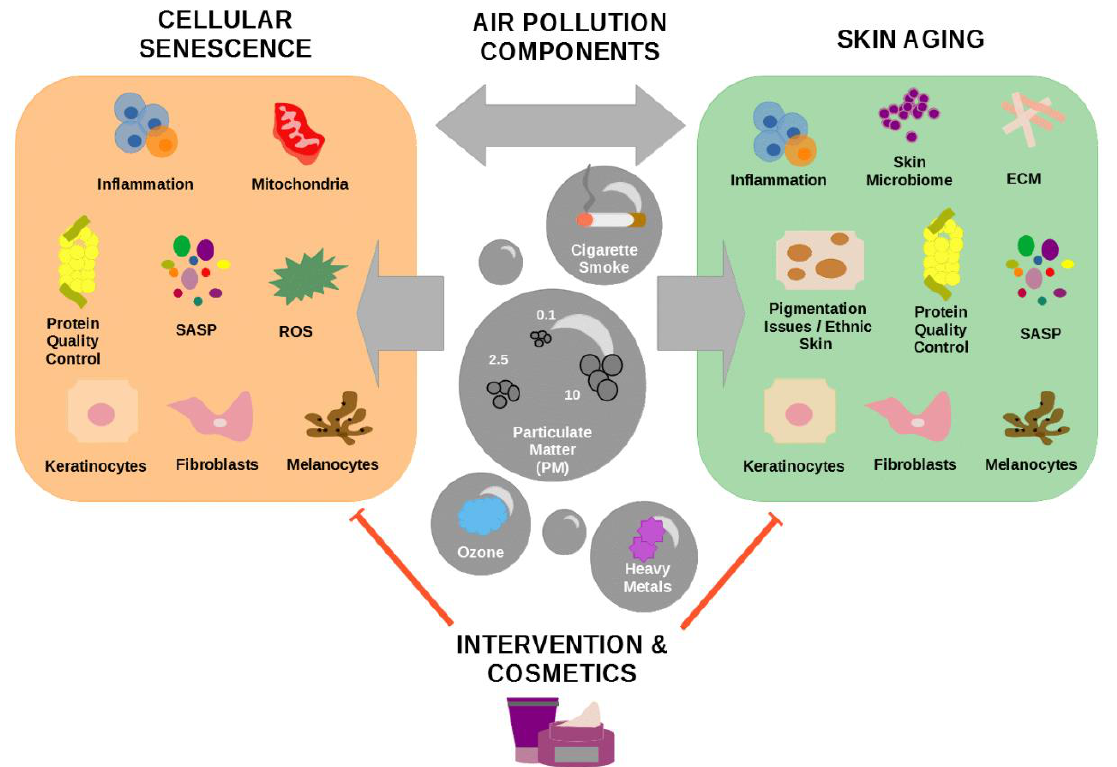
Figure 1. The interplay between air pollution, cellular senescence, and skin aging. The review focuses on the topics inflammation, protein quality control, mitochondrial dysfunction, reactive oxygen species (ROS), and senescence-associated secretory phenotype (SASP) in cutaneous skin cells during senescence induced by air pollution. Additionally, we discuss how air pollution components such as particulate matter (PM), ozone, heavy metals, and cigarette smoke impact skin aging. Finally, we summarize the latest information about interventions and cosmetics which were shown to prevent the impact of air pollution in the processes of cellular senescence and skin